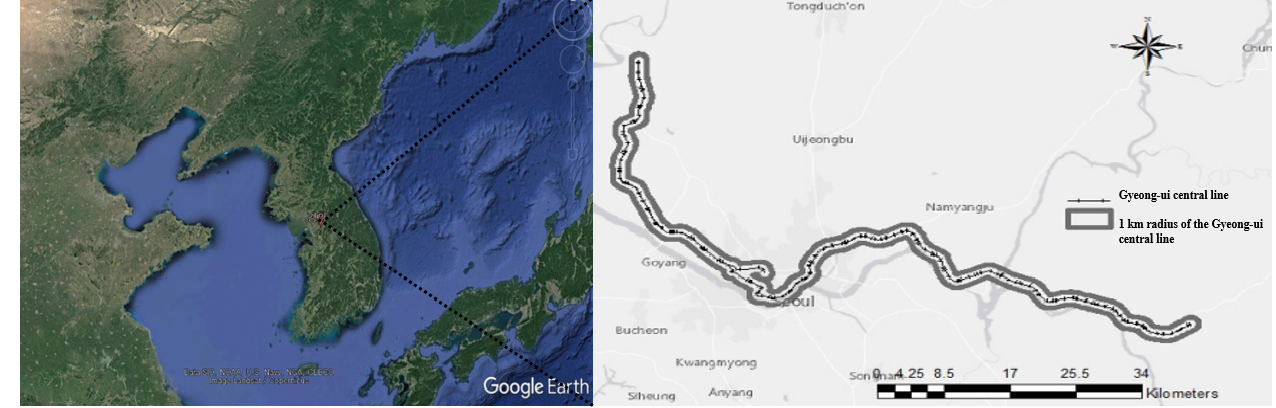
Figure 1. Gyeong-ui Central Line.